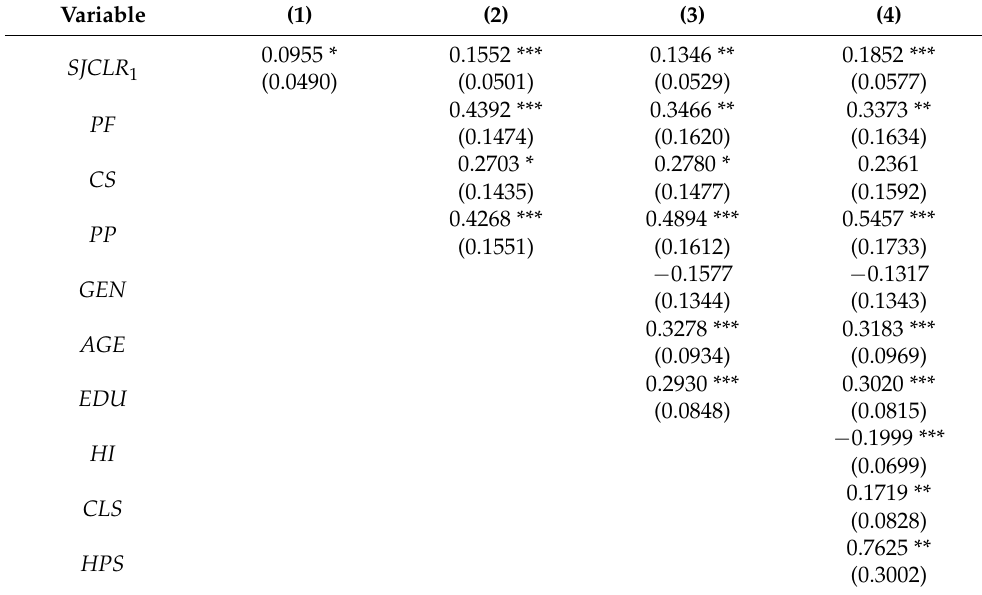
Table 4. Ordered probit model regression